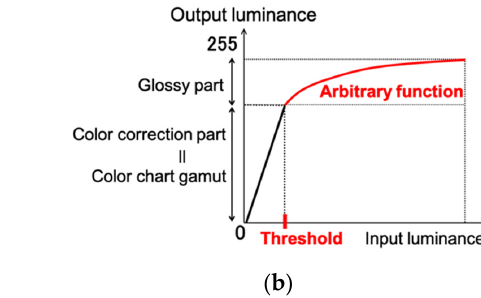
Figure 8. Images with logarithmic function applied (Xperia1). ( a ) threshold: 0.9 parameter: 1.5; ( b ) threshold: 0.9 parameter: 3.5.